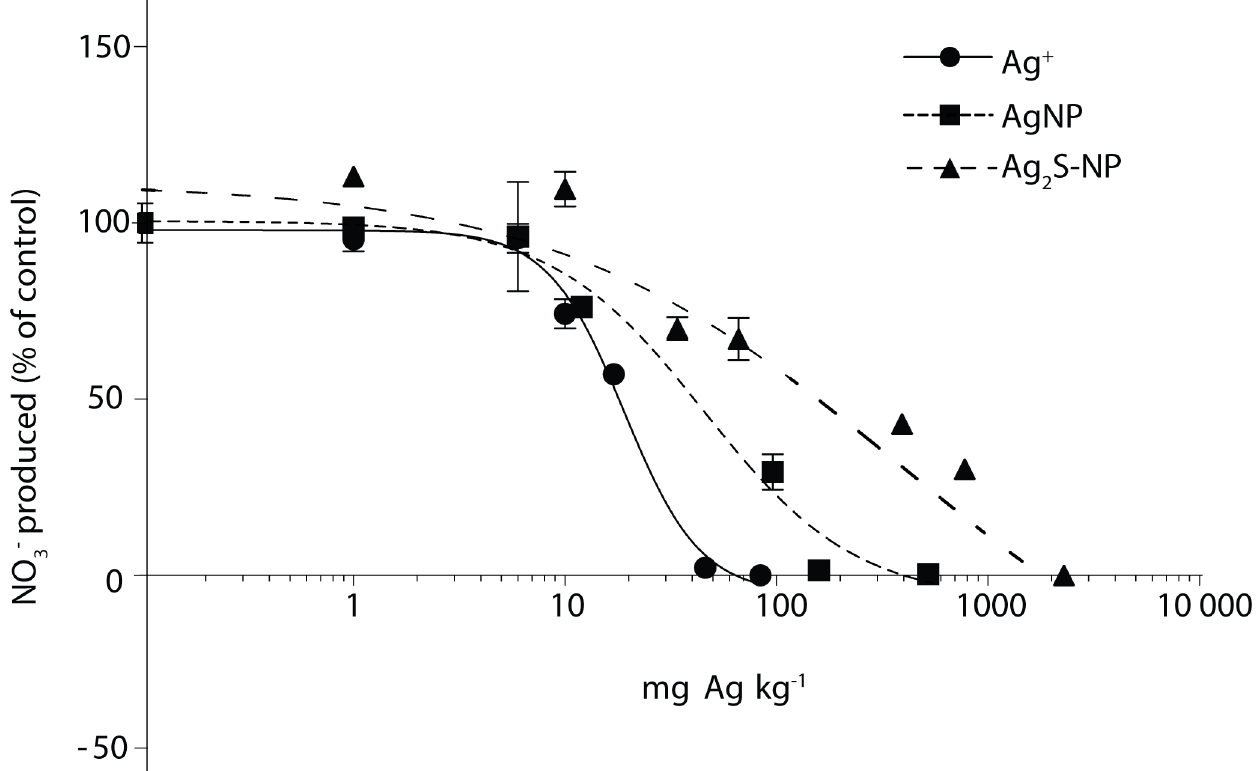
Fig 2. Dose-response curves for NO 3- production in soil over 28 d. Ionic Ag (Ag + – dashed line); Ag nanoparticles (AgNP – short dashed line); and Ag sulfide nanoparticles (Ag 2 S-NP – long dashed line). Mean values ( n = 3) ± 1 standard deviation are shown. Silver concentrations are on a log 10